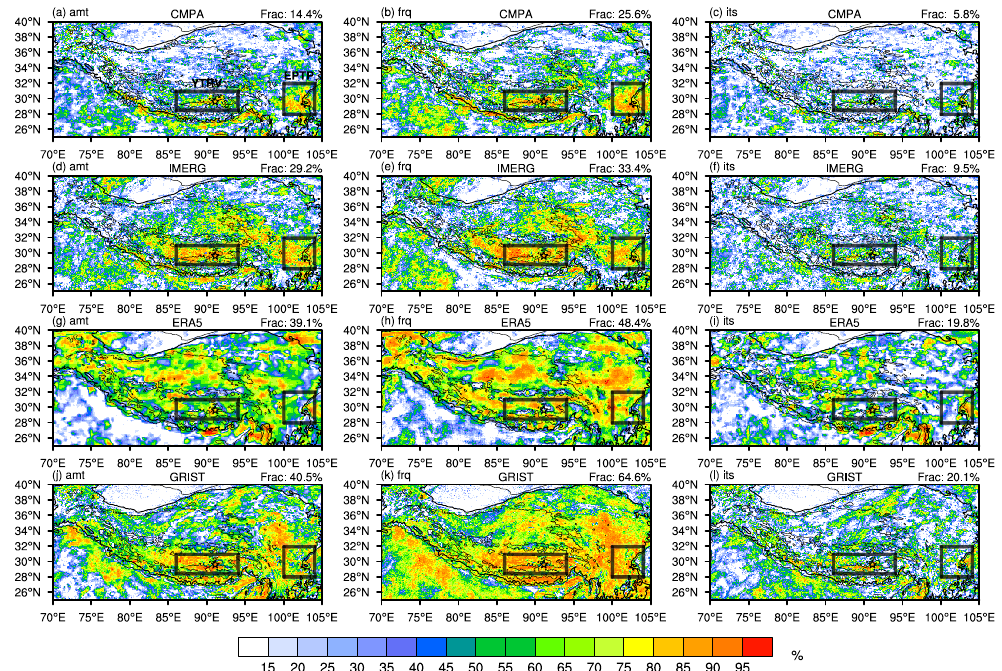
Figure 4. Spatial distribution of the first harmonic’s variance of Fourier analysis (%; left: amount; middle: frequency; right: intensity). Fourier transformation is applied to the 24-h rainfall cycle of CMPA ( a – c ), GPM ( d – f ), ERA5 ( g – i ), and GRIST ( j – l ). The superscript numbers are the fraction of single-peak grids. The two black rectangles indicate selected sub-regions with a strong diur- nal features (YTRV: Yarlung Tsangpo River Valley; EPTP: Eastern Periphery of Tibetan Plateau). The pentagram indicates the location of Lhasa. The thick black contour depicts terrain heights of 2000 m, and the thin black contours represent 1000 and 4750